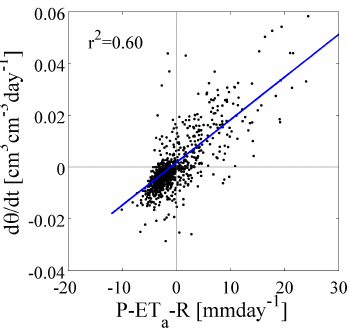
Figure 9. Time derivative of volumetric soil water content (average of all depth) vs. the water balance